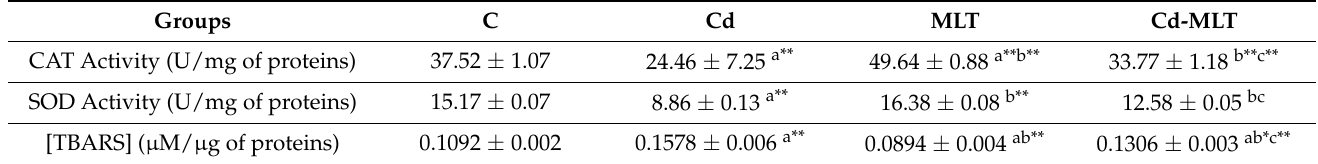
Table 2. Effect Cd and/or MLT on testicular oxidative-stress